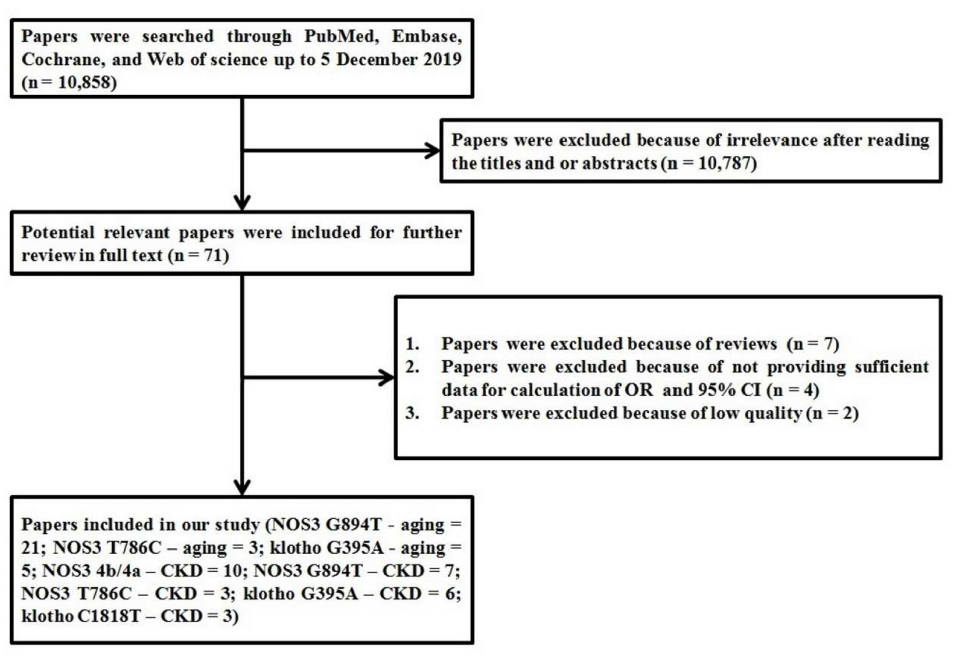
Figure 1. PRISMA flowchart of paper selection in our study.